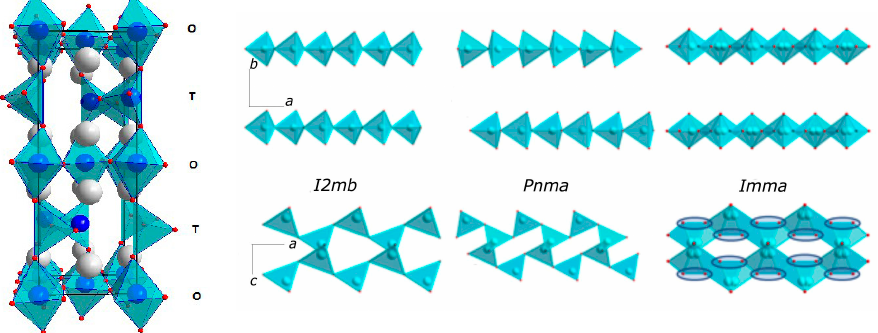
Figure 1. Brownmillerite structure with alternating octahedral (O) and tetrahedral (T) chains. On the right, different switching arrangements for the (MO 4 ) ∞ -tetrahedral chains in brownmillerite-type frameworks. Full ordering is achieved for a description in I2mb and Pnma , showing different relative but ordered chain arrangements for different layers, while the superposition of both arrangements results, on an average scale, in split positions for the in-plane oxygen and M-atoms, which can be described in the Imma space group symmetry.